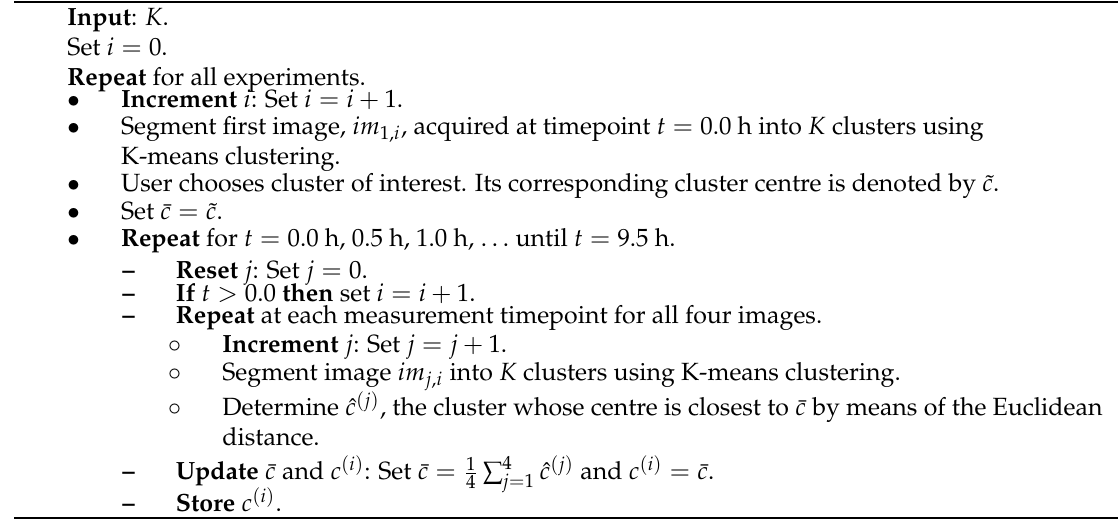
Algorithm 1: Determining the region of interest in images.